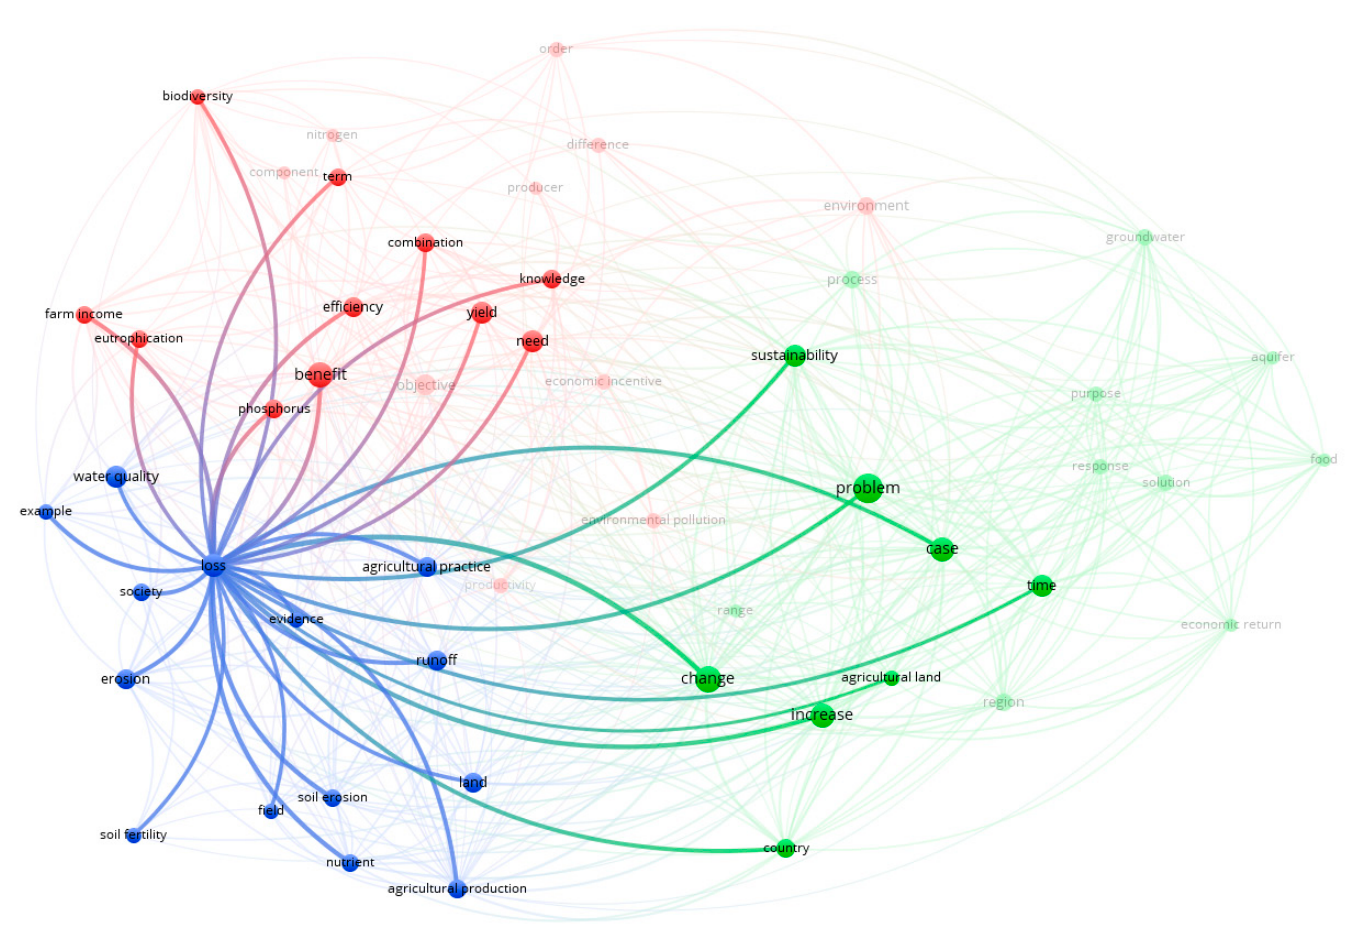
Figure 4. Interrelationships with the term “loss” from cluster 3.